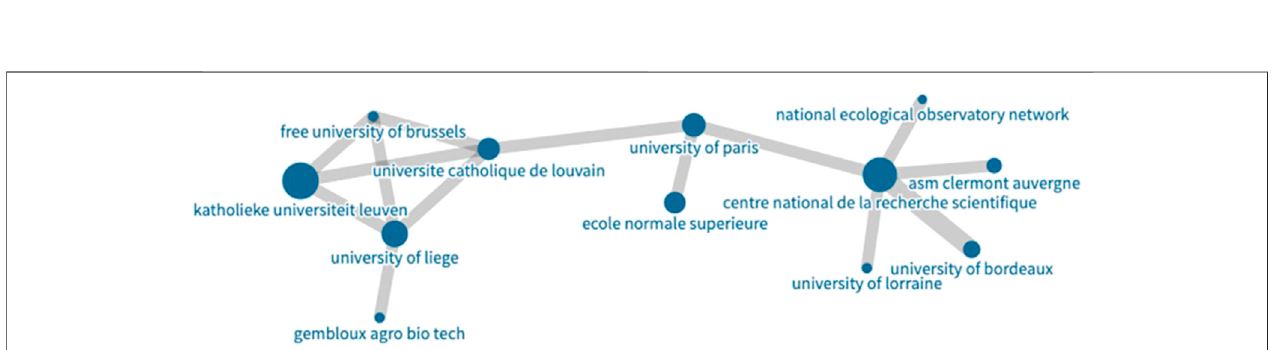
FIGURE 10 | Community two from the largest component of the complete graph of institutional collaboration ( Figure 6B ). This community is not connected strongly to the central hub of large in fl uential institutions and shows that geographic proximity also de fi nes collaborative communities in SDG research.